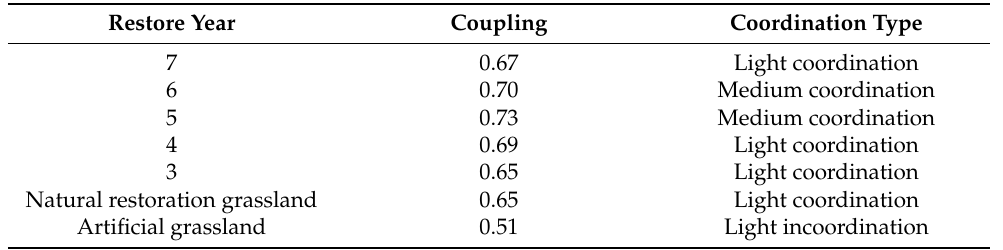
Table 5. Coordination evaluation model of plant diversity and soil system coupling in different restoration